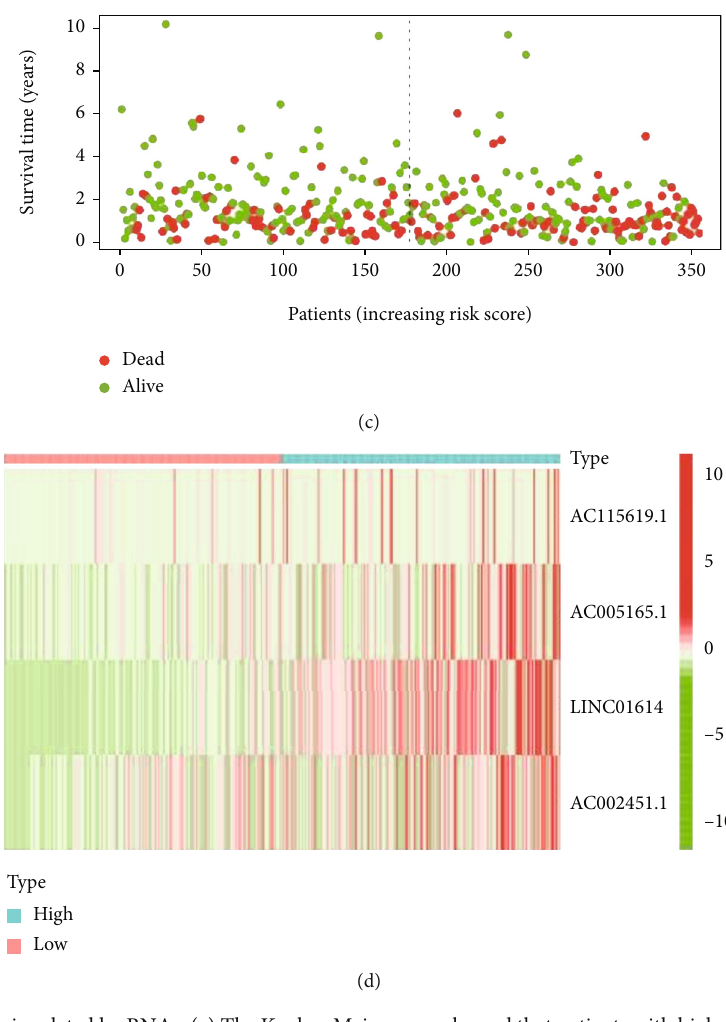
Figure 3: Feature of ferroptosis-related lncRNAs. (a) The Kaplan-Meier curve showed that patients with high risk displayed a shorter overall survival than those with low risk. (b) The median value and distribution of the risk scores. (c) The distribution of OS status. (d) Heat map of four